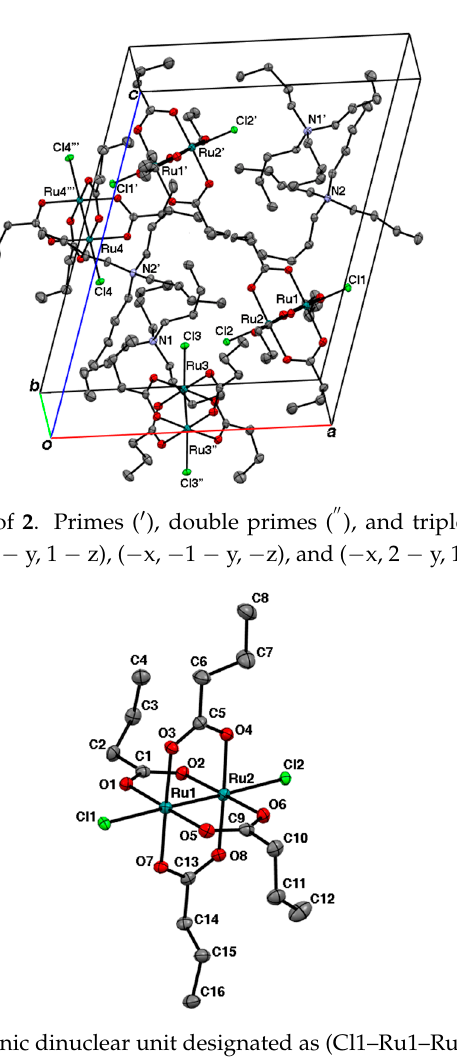
Figure 4. Packing diagram of 3 . Primes ( ′ ) and double primes ( ′′ ) refer to the equivalent positions ( − x, − y, − z) and ( − x, y, 1/2 − z), respectively. 2.3. Magnetic Properties The temperature dependences of magnetic susceptibilities and effective magnetic moments of 1 , 2 , and 3 are shown in Figures 5–7, respectively. The magnetic moments at 300 K were 3.97 (for 1 ), 4.00 (for 2 ), and 3.97 µ B (for 3 ), respectively, indicating the existence of three unpaired electrons within the